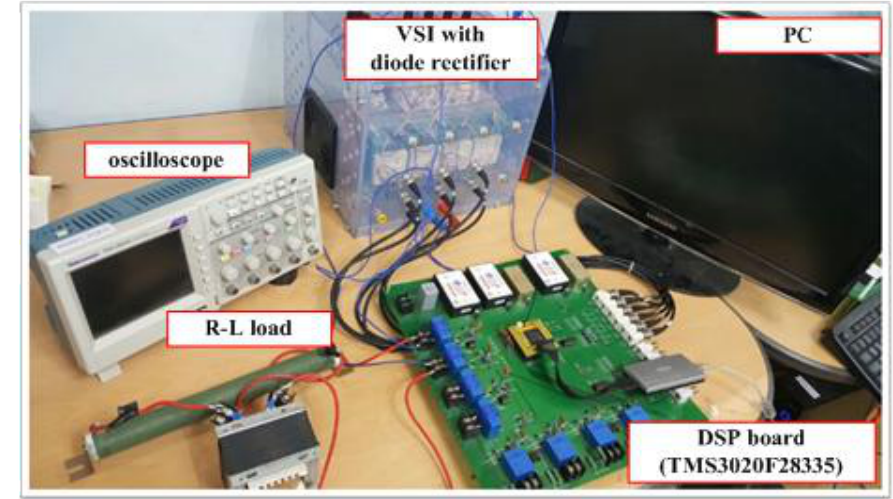
Figure 12. Photograph of the prototype setup for single-phase VSI.